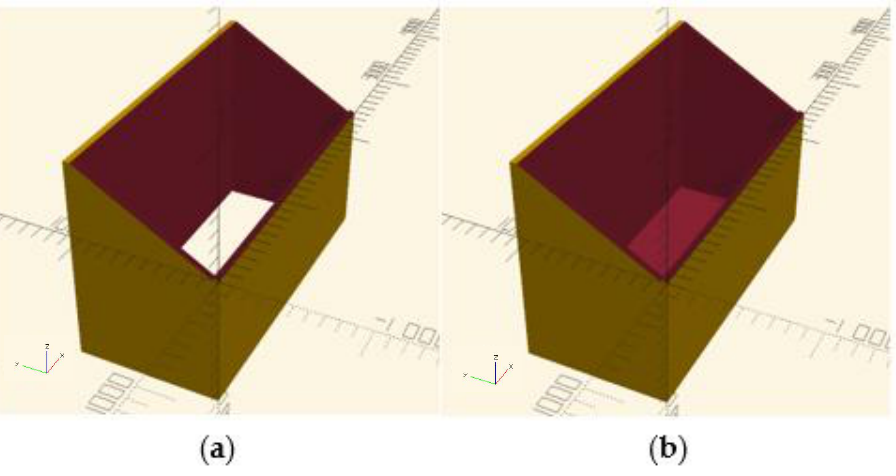
Figure 5. Interior of the POSCAS ( a ) with no bottom and ( b ) with a bottom.